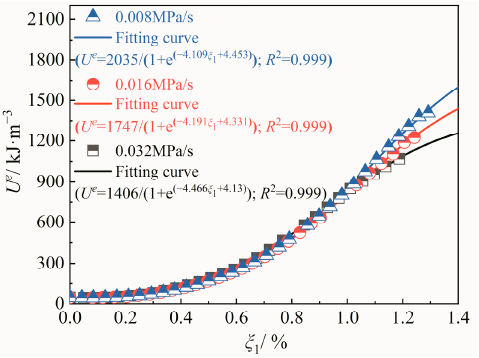
Figure 6. Relationship between pre-peak elastic strain energy of diorite and self-repression model under different unloading confining-pressure rates.